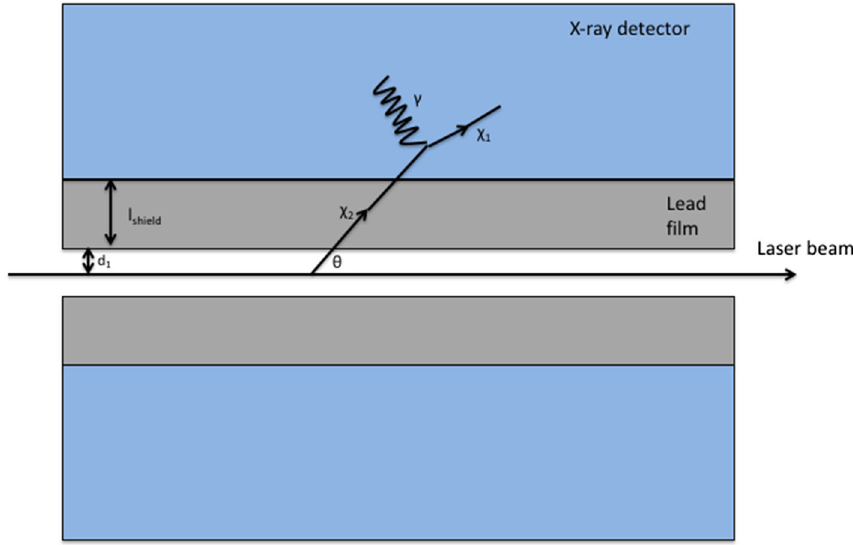
Fig. 1 Scattering of excited dark matter from a 3.5 keV laser, and subsequent decay to photons (not to scale)